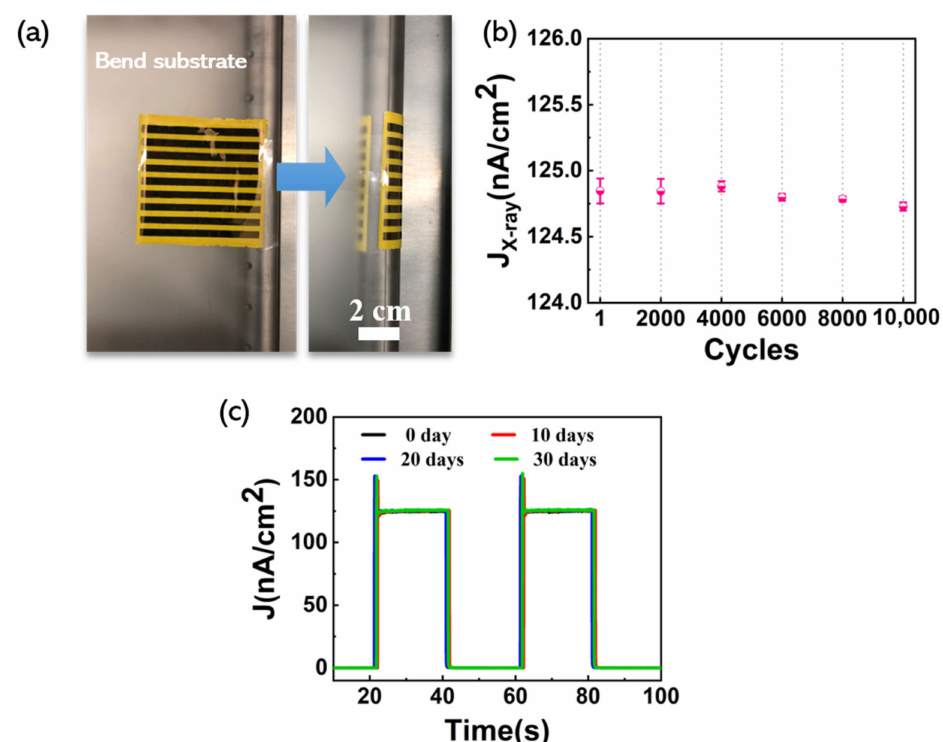
Figure 7. ( a ) Experimental set-up for testing the flexibility of the devices (bending radius is 1 cm); ( b ) J X-ray of the devices measured after 1, 2000, 4000, 6000, 8000, and 10,000 curling cycles; ( c ) time- dependent J of the detector measured every 10 days. The data displayed in Figure 7 was measured under a dose rate of 11.97 mGy air s − 1 at 150 V bias voltage and in flat-substrate